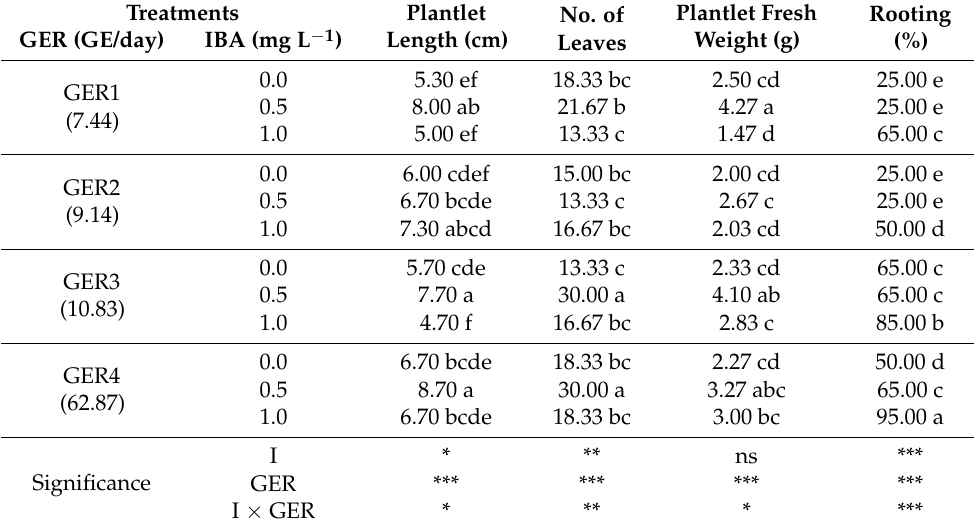
Table 6. Effect of gas exchange rate and indole butyric acid on in vitro rooting of G. paniculata hyperhydric recovered microshoots after four weeks. All cultures were kept at light density of 60 µ mol m − 2 s − 1